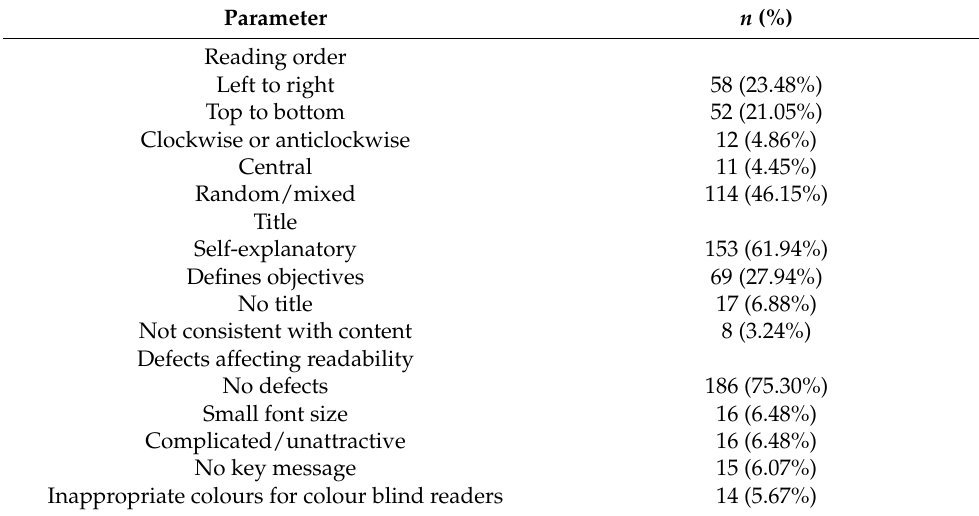
Table 3. Characteristics of the layout of included infographics: reading order, title and defects affecting